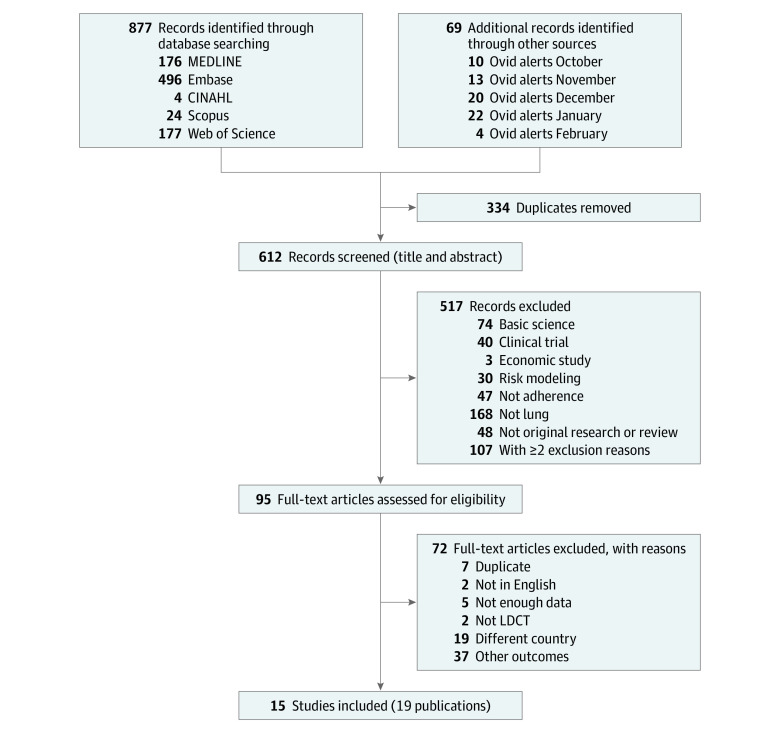
Flow Diagram of Study DispositionLDCT indicates low-dose computed tomography.